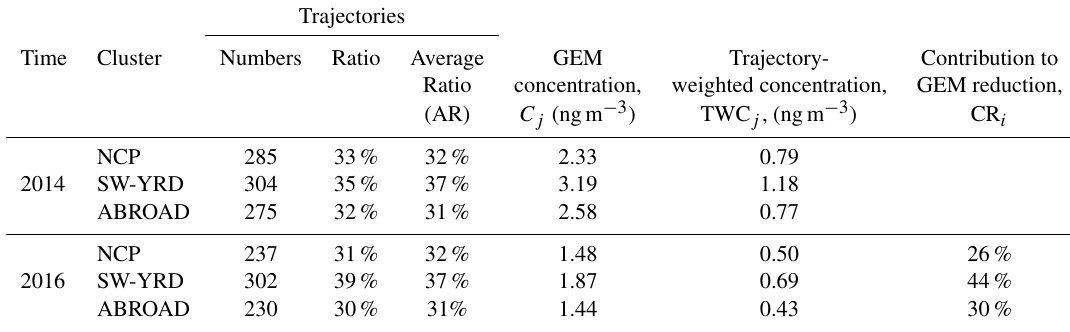
Table 3. The statistics of cluster and estimated contribution of GEM reduction in 2014 and 2016. Trajectories Cluster Numbers Ratio Average GEM Trajectory- Contribution to Ratio concentration, weighted concentration, GEM reduction, (AR) C j (ngm − 3